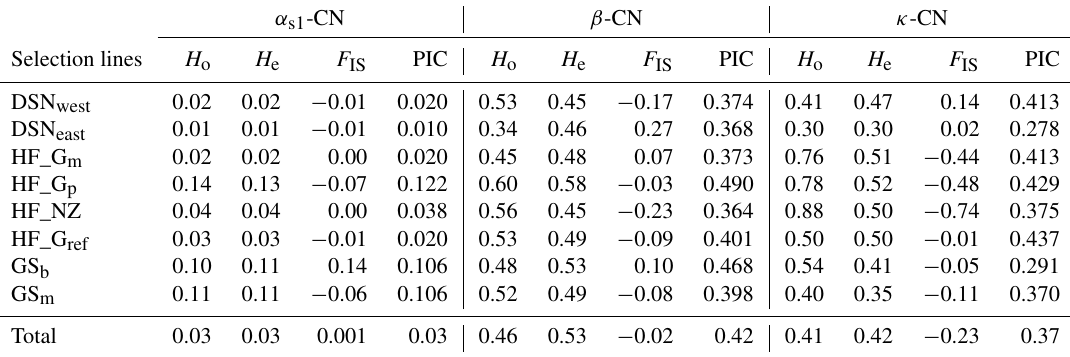
Table 3. The breed- and casein-wise estimates of observed ( H o ) and expected heterozygosity ( H e ), Wright’s inbreeding coefficient ( F IS ; Wright, 1965) and polymorphic information content (PIC).